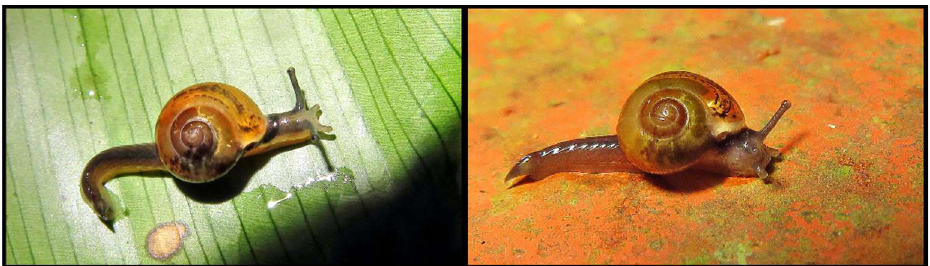
Figure 3. Live Ovachlamys fulgens photographed by iNaturalist user Rogerio Dias (username “rogerriodias”) in Alto da Boa Vista, Rio de Janeiro, RJ, Brazil. Left: observation #74273898 (3 March 2020); right: observation #74780463 (10 February 2021). Images extracted from iNaturalist (CC BY-NC 4.0).